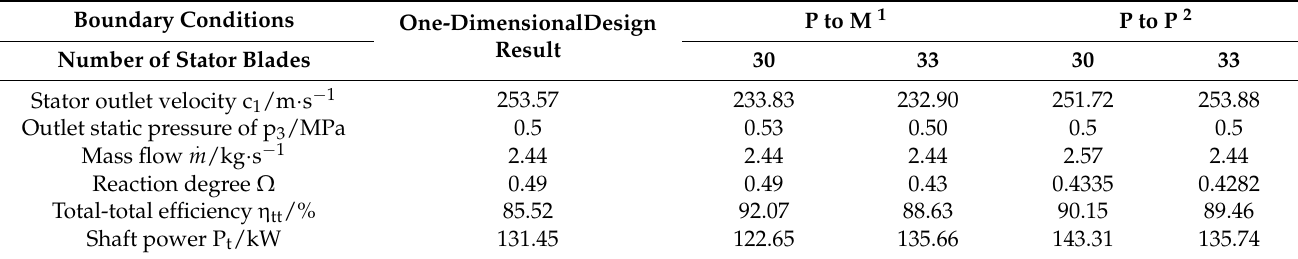
Table 5. Comparative analysis of verification